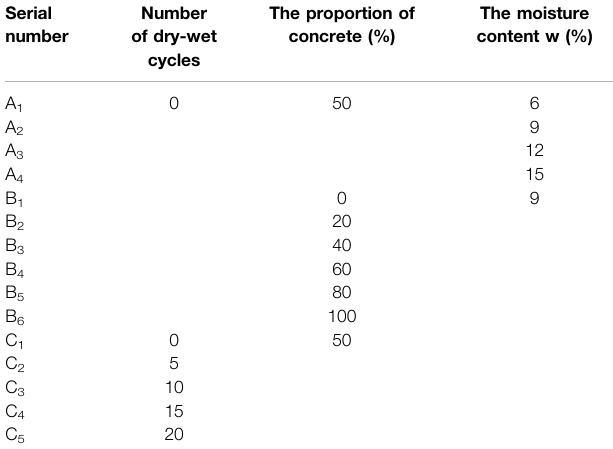
TABLE 3 | The scheme of the consolidation test.